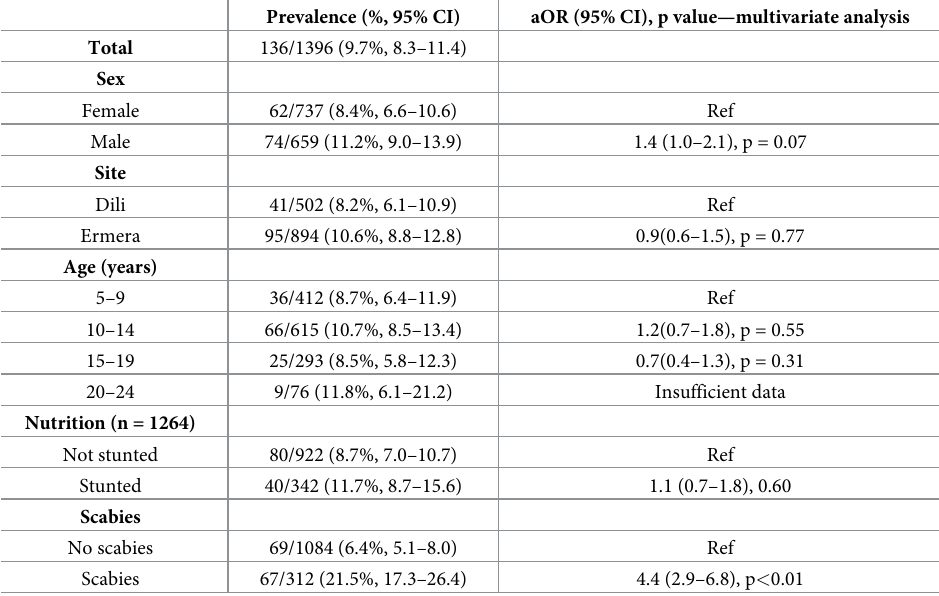
Table 3. Prevalence of impetigo and adjusted odds ratio for variables in multivariate analysis.